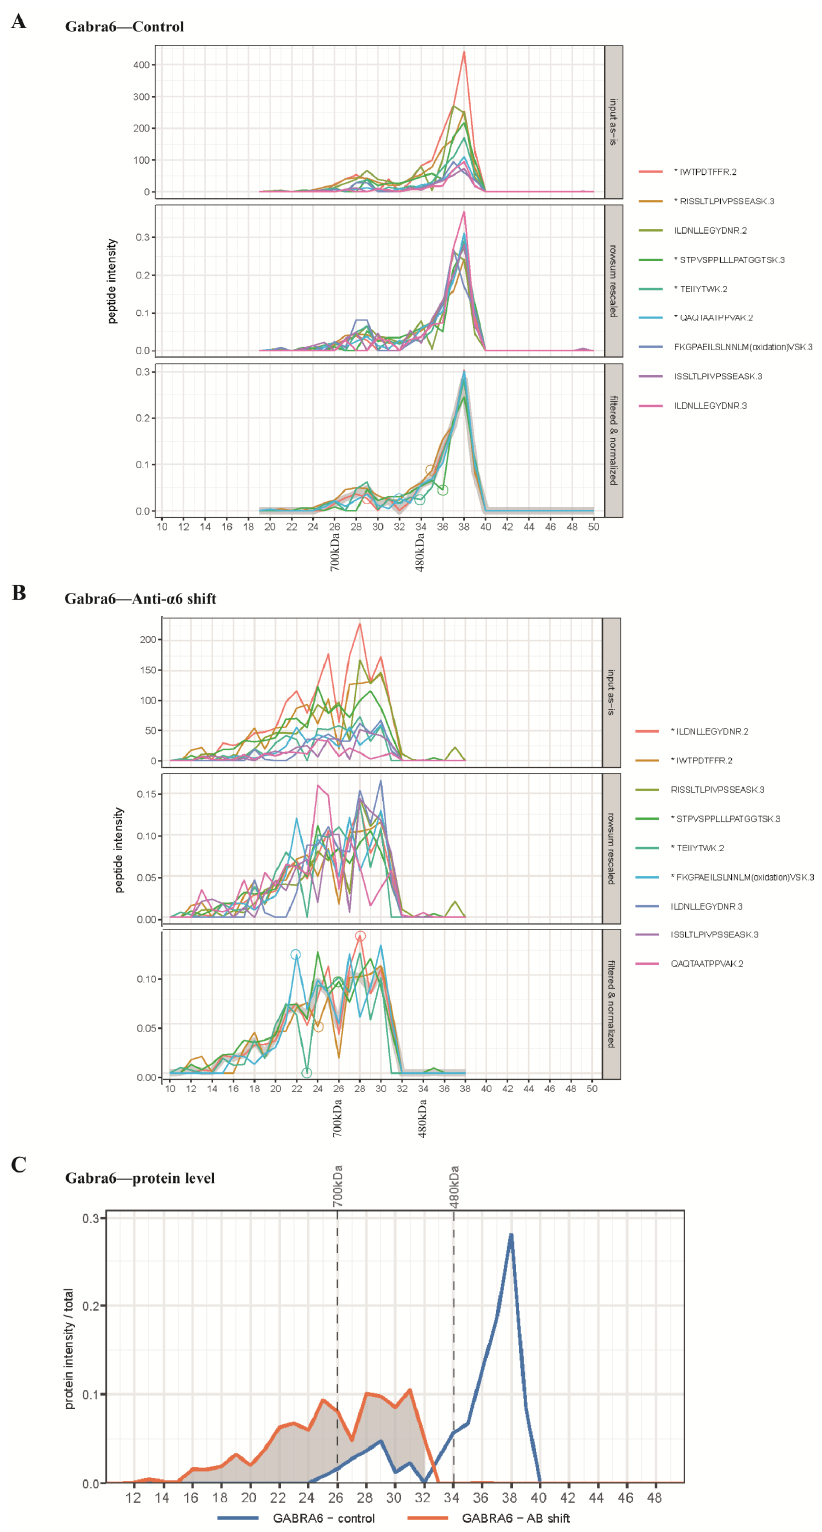
Figure 1. Peptides and protein profiles of Gabra6 in the antibody shift experiment. ( A ) Profiles of identified Gabra6 peptides over the gel slices in the control group, upper panel: top 9 most abundant original peptides profiles (raw data); middle panel: intensity rowsum rescaled peptides profiles, peptide intensity in every gel piece is rescaled by sum of intensity over all gel piece; lower panel: filtered and normalized peptide profiles show the most similar subset of 5 peptides (labelled with